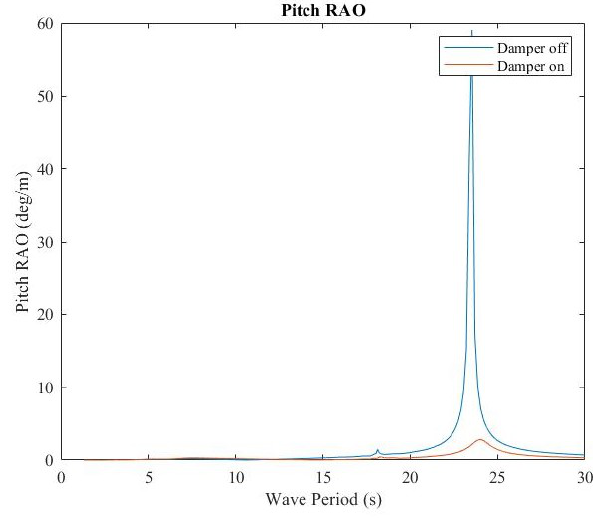
Figure 23. RAO comparing the platform pitch with the TMD on and off.